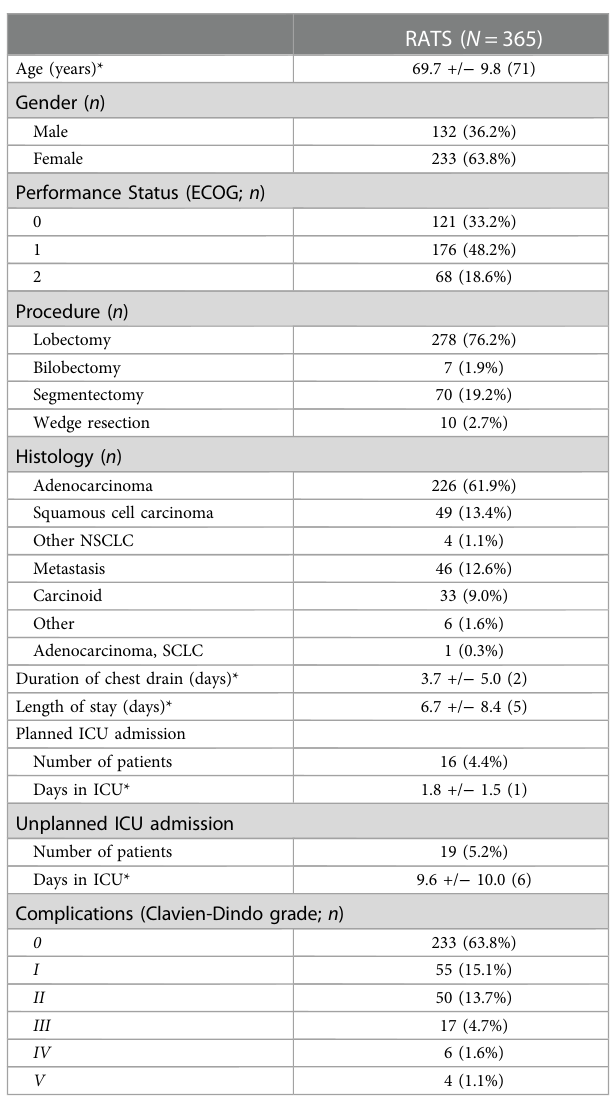
TABLE 1 Patient characteristics of the RATS